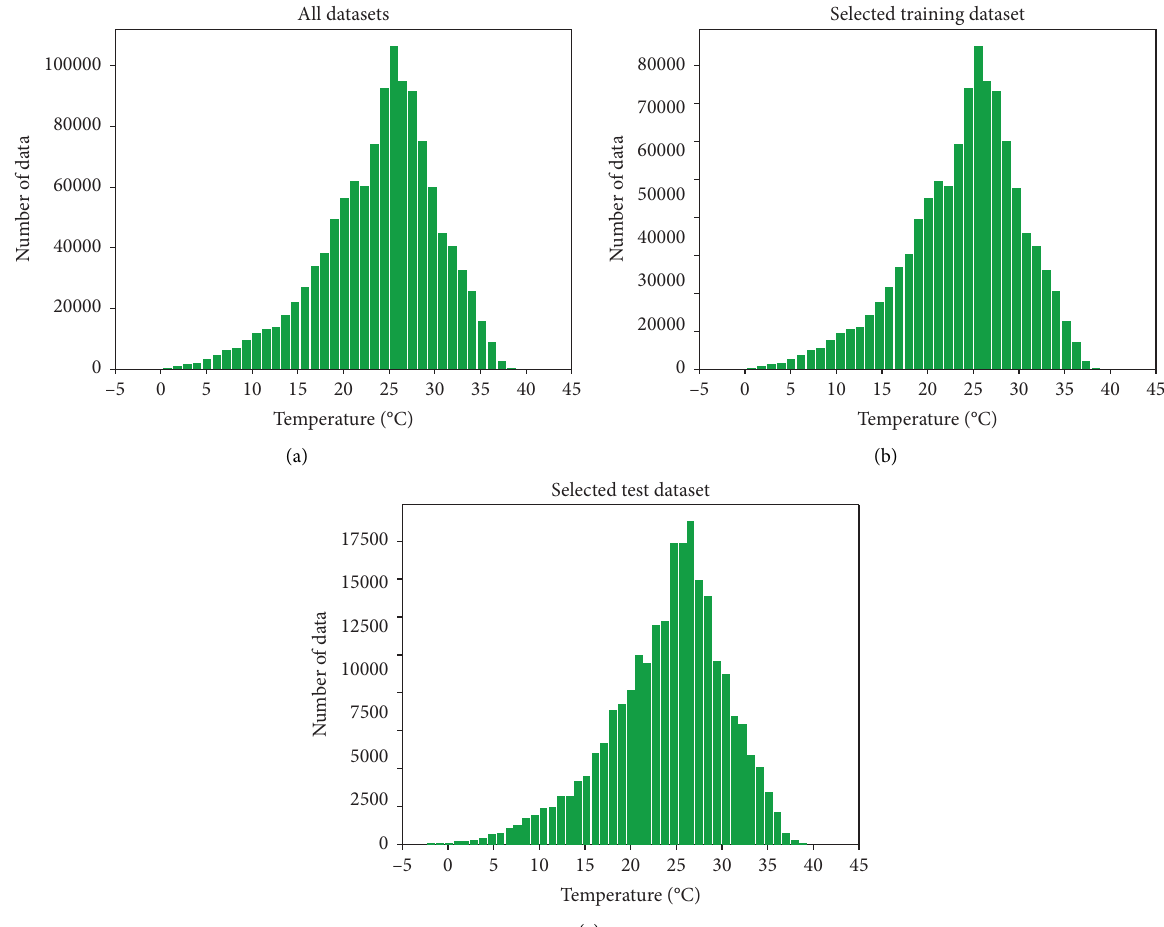
Figure 2: Histograms of training data for machine learning. (a) All datasets, (b) training dataset, and (c) test dataset.